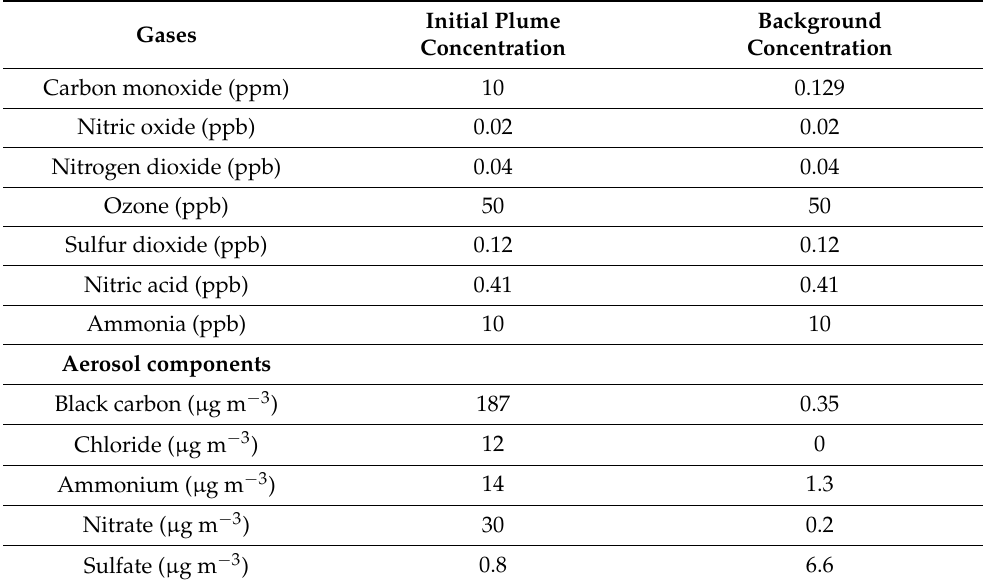
Table 2. Initial plume conditions for gases [12] and background inorganic PM 2.5